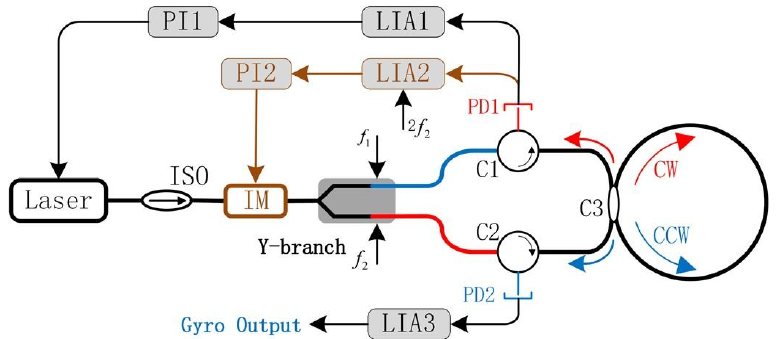
Figure 11. The basic configuration of the RIOG system with light intensity feedback. Reprinted with permission from ref. [34]. Copyright 2020 SPIE.